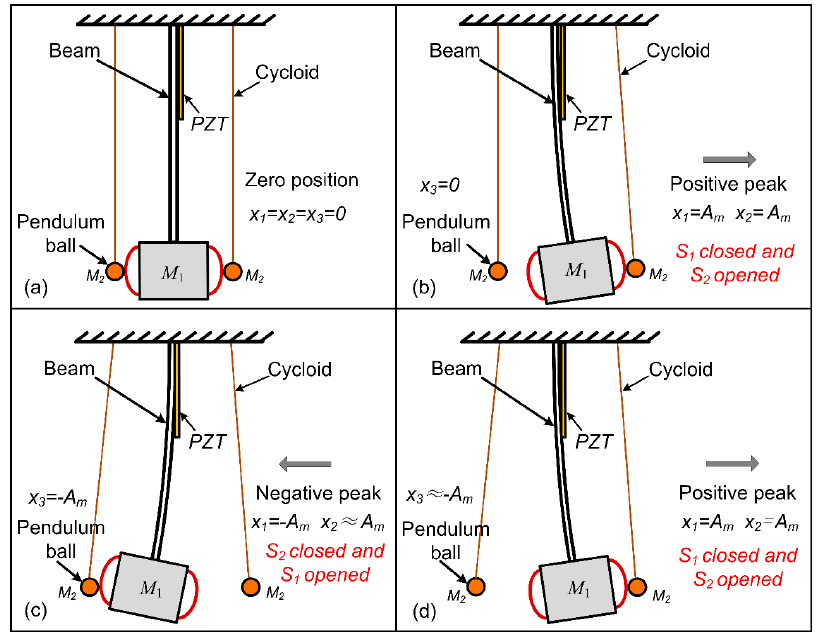
Figure 4. Working principle of the proposed self-adaptive mechanical switch by several snapshots of the first period: ( a ) initial status; ( b ) positive peak; ( c ) negative peak; ( d ) repeated positive peaks.